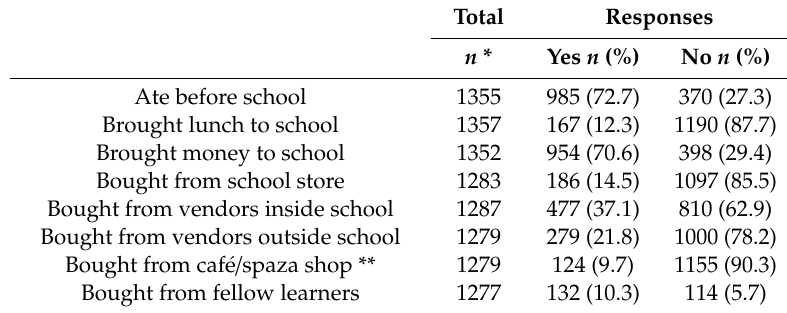
Table 3. Dietary practices made in the school environment by grade 8–12 learners on the day the school was